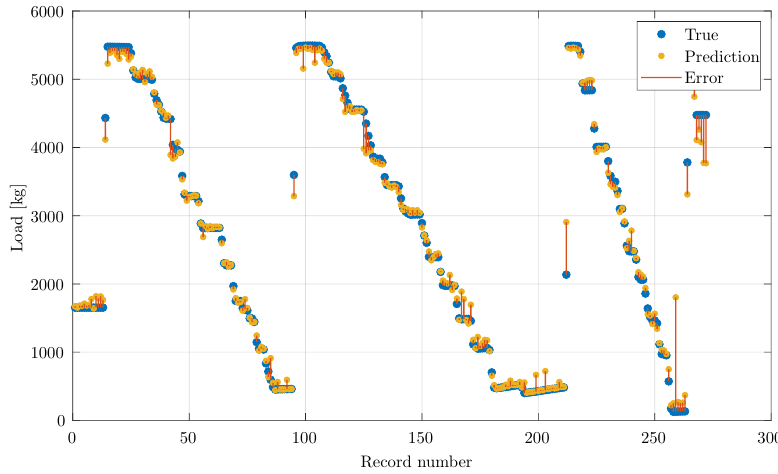
Figure 9. Network learning results.